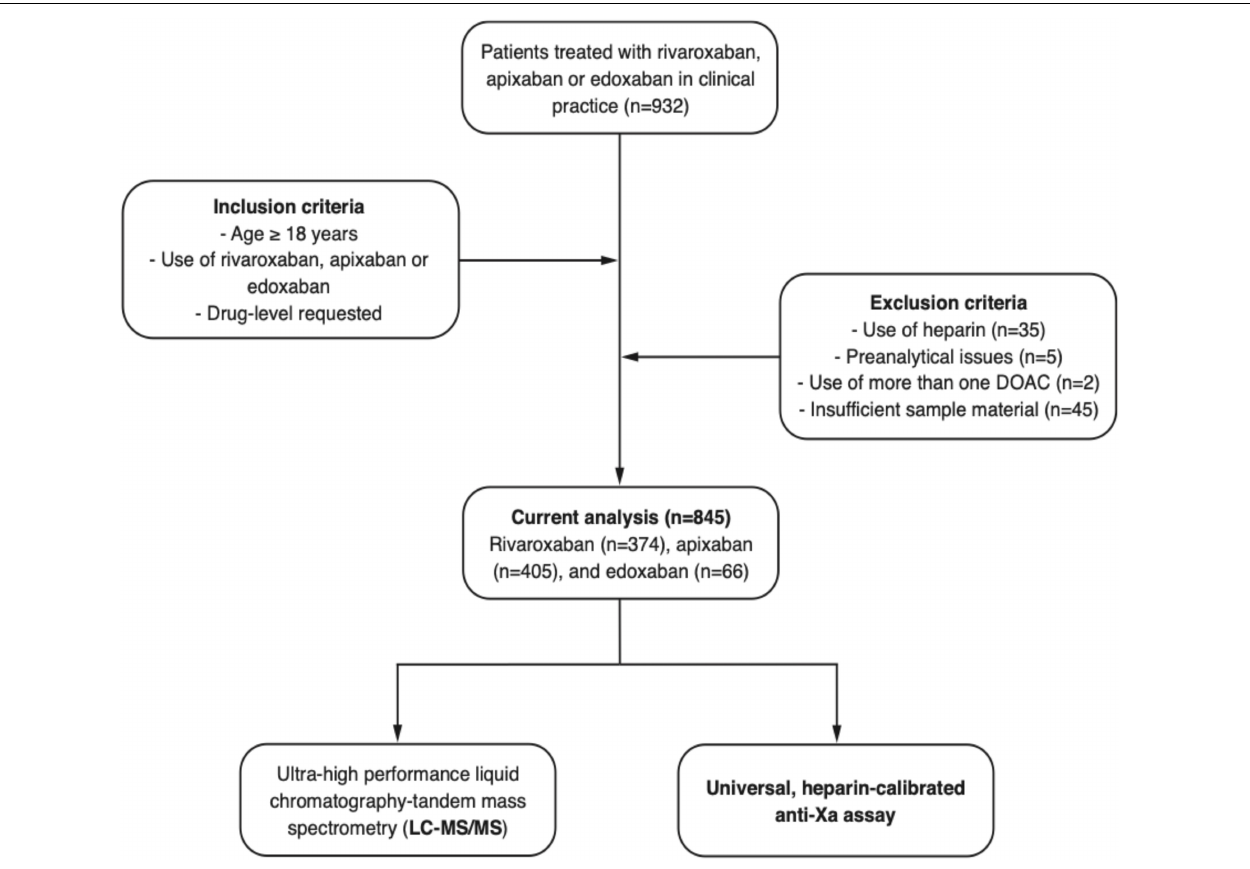
FIGURE 1 | Flow of the patients. A prospective, multicentre cross-sectional study was conducted to test the accuracy of a heparin-calibrated anti-Xa assay for the measurement of rivaroxaban, apixaban, or edoxaban plasma levels in clinical